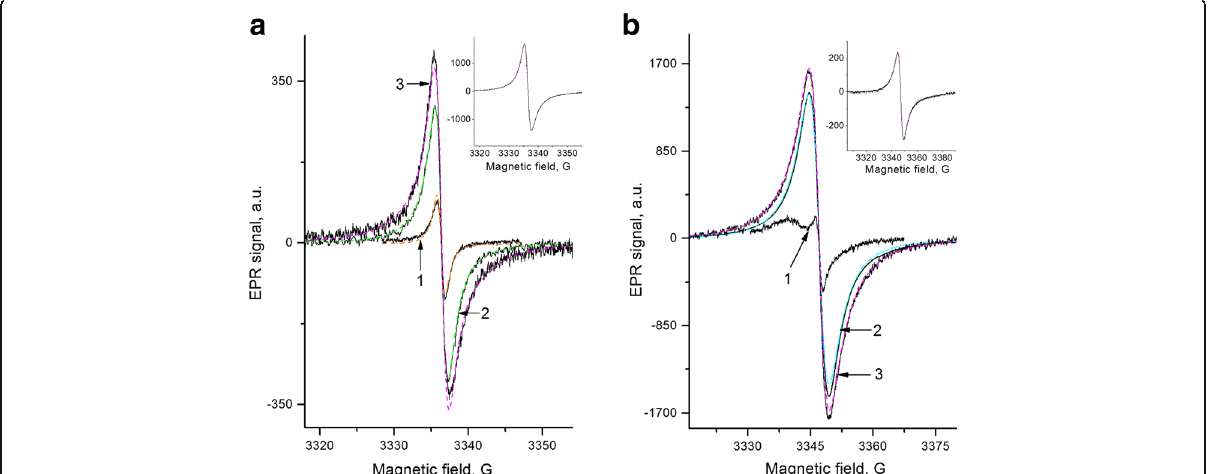
Fig. 1 EPR spectra of fullerene, FS, FB, and composites Phenylon C-2/FS, FB. a. 1 — initial samples of the fullerene C60, 2 — fullerene soot (FS), 3 — fullerene black (FB) at room temperature. Dashed lines are the calculated signals (Table 1). ν = 9350 MHz. The insert: EPR spectrum of the fullerene black at T = 30 K.